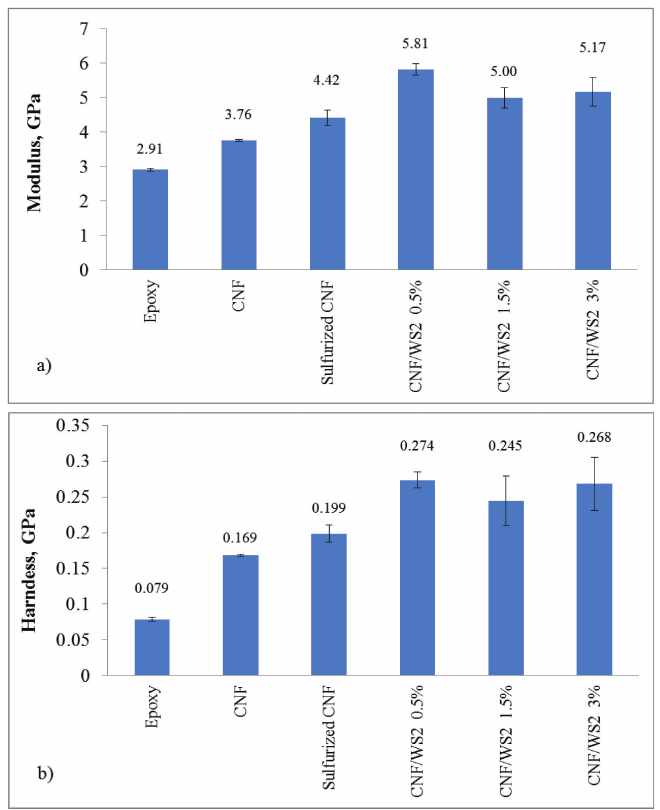
Figure 8. Mechanical properties of epoxy composites . All composites contained 99% epoxy and 1% loading of filler nanostructures: CNF, sulfurized CNF or hybrid CNF/IF-WS For the later, the hybrids contained mostly carbon fibers, with only 0.5, 1.5, and 3% of IF-WS . ( a ) Modulus data and ( b ) Hardness 2